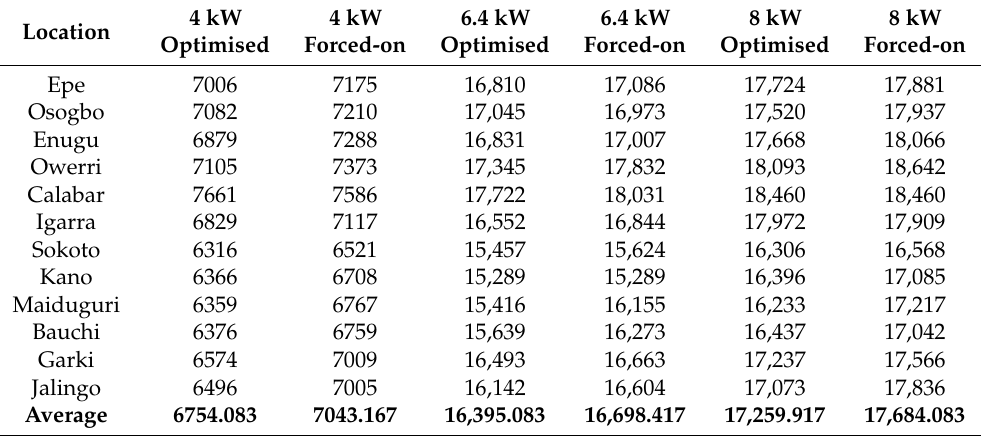
Table 8. Simulated fuel consumption for the sites